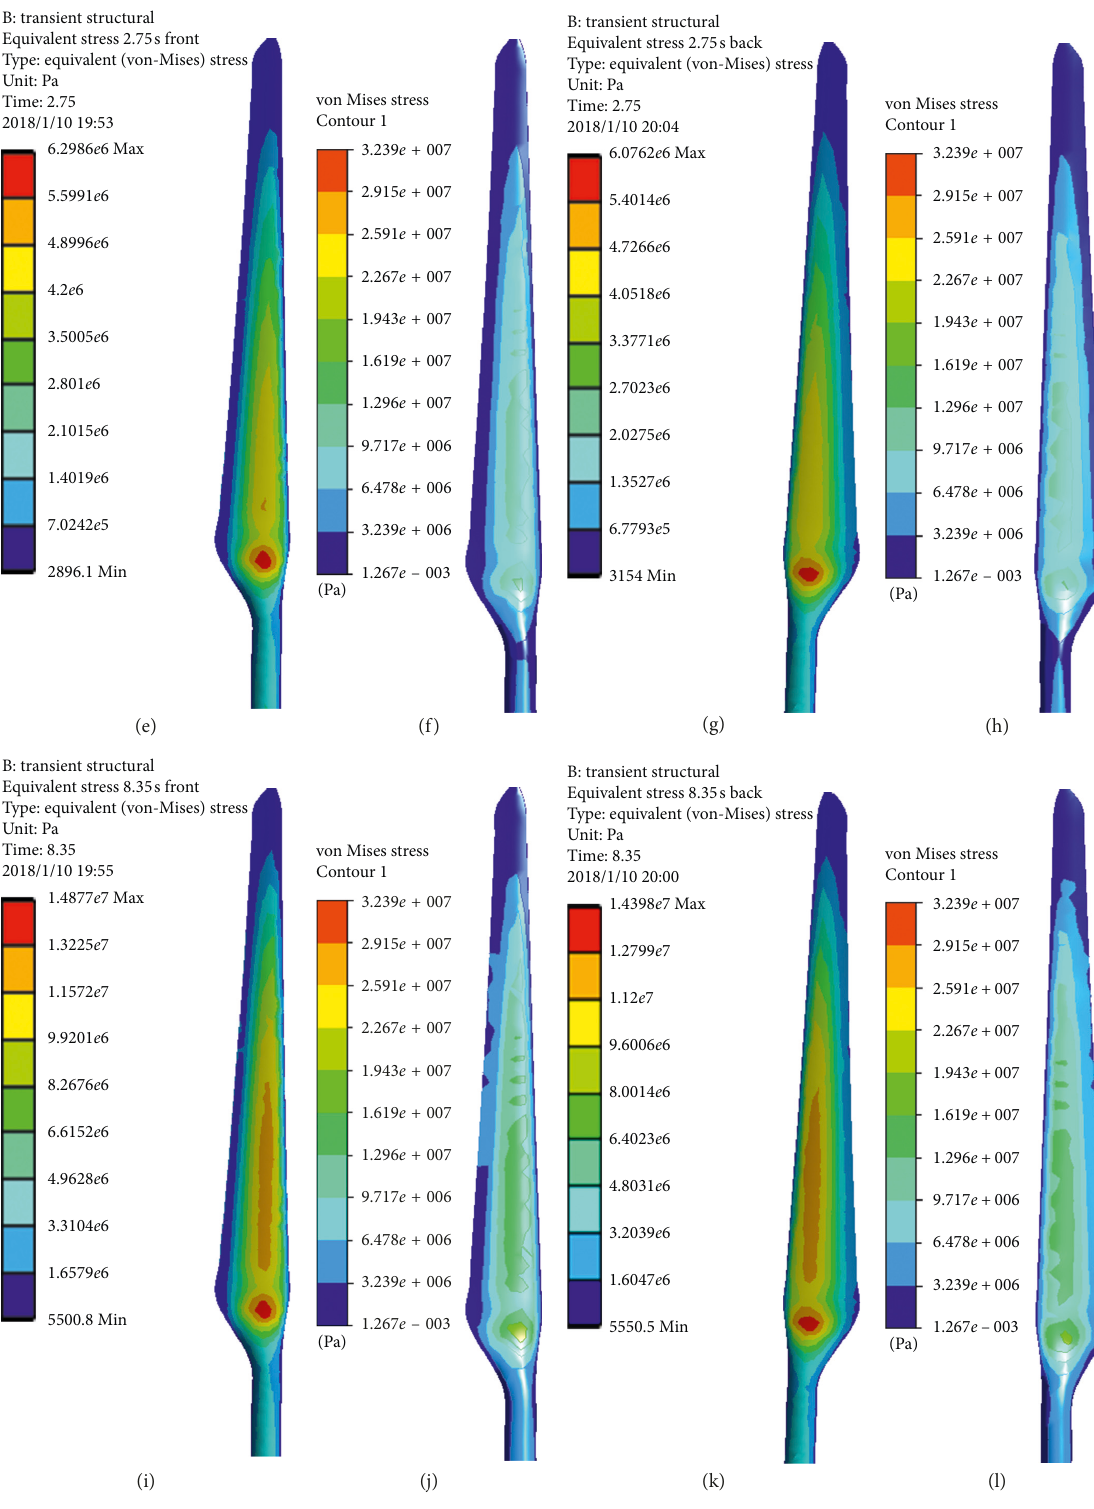
Figure 10: Mises stress cloud of the windward and leeward at different times under one- and two-way FSIs: (a) windward side in one-way FSI@0.35 sm; (b) windward side in two-way FSI@0.35 s; (c) leeward side in one-way FSI@0.35 s; (d) leeward side in two-way FSI@0.35 s; (e) windward side in one-way FSI@2.75 s; (f) windward side in two-way FSI@2.75 s; (g) leeward side in one-way FSI@2.75s; (h) leeward side in two-way FSI@2.75 s; (i) windward side in one-way FSI@8.35 s; (j) windward side in two-way FSI@8.35 s; (k) leeward side in one-way FSI@ 8.35s; (l) leeward side in two-way FSI@8.35